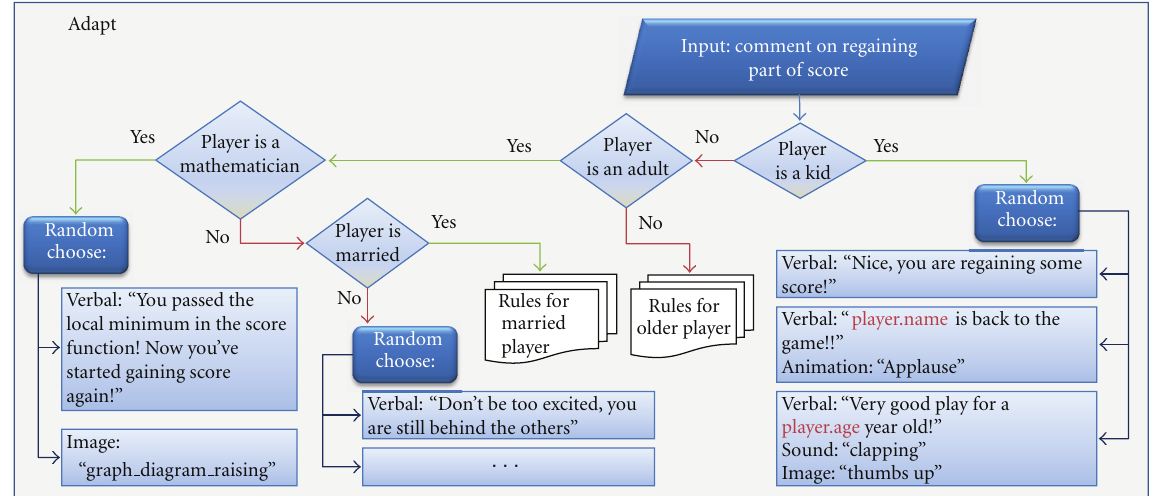
Figure 9: How a presenter character’s decision can be further adapted to match a player profile. Notice that the final comment choice is made among reaction combos. In verbal comments, the “player.name” and “player.age” will be replaced with the corresponding attributes from player